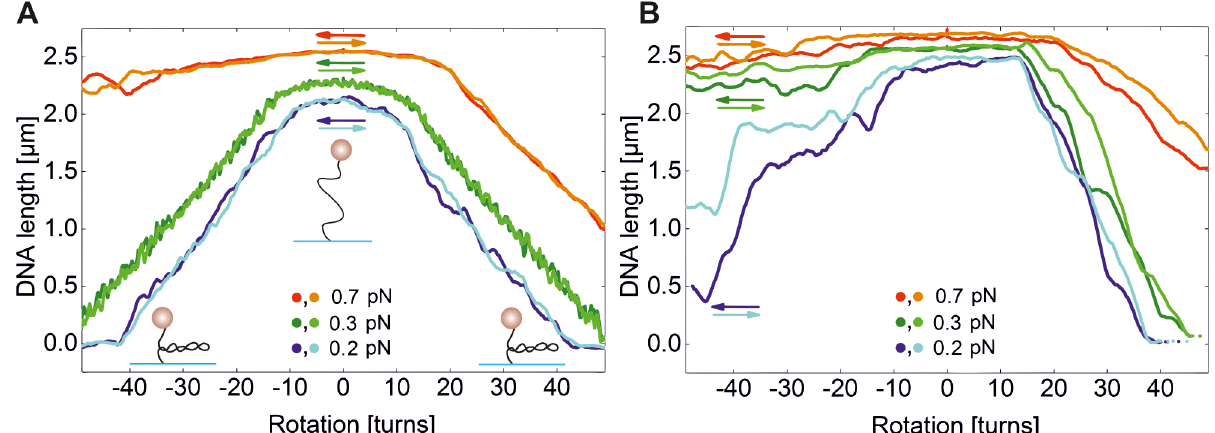
Fig 3. Altered supercoiling response of dsDNA in presence of TrmBL2 for different forces. Arrows indicate the sense of rotation whereas the colour indicates the applied force. (A) Supercoiling curves in absence of TrmBL2 at different forces. The lighter and darker shade of a given color show curves that were obtained when inducing negative and positive supercoiling, respectively. Small cartoons of the plectoneme formation are shown. (B) Supercoiling curves taken at the same conditions in presence of 4.6 μ M TrmBL2. The presented curves were all recorded using the same